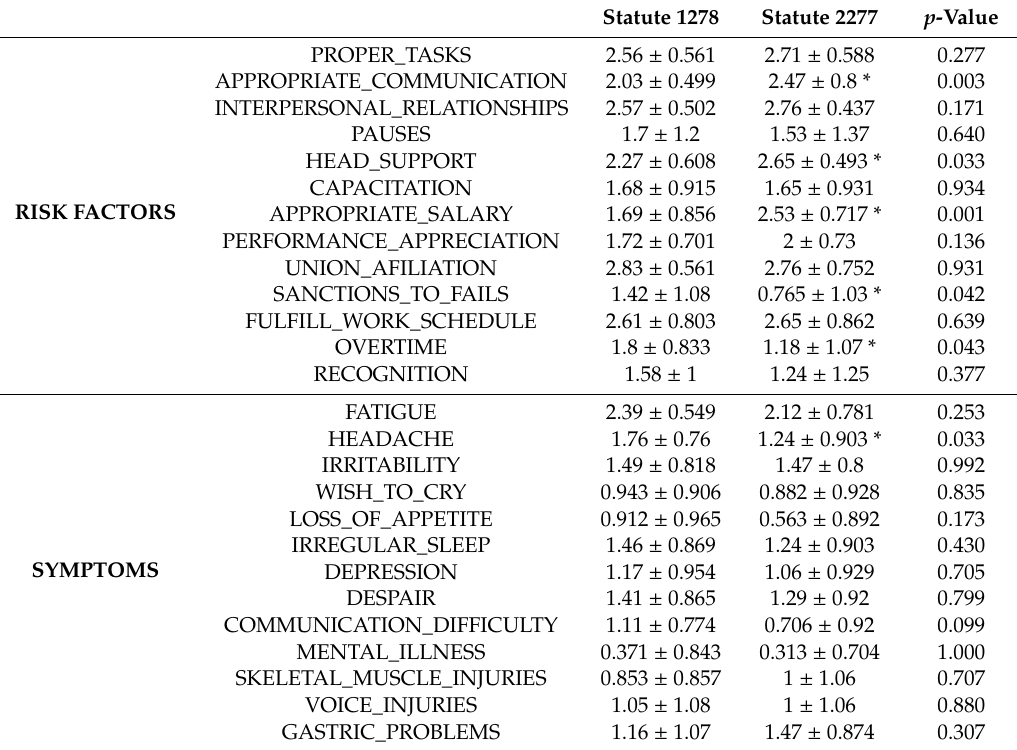
Table 2. Statistical analysis of risk factors and symptoms of burnout.